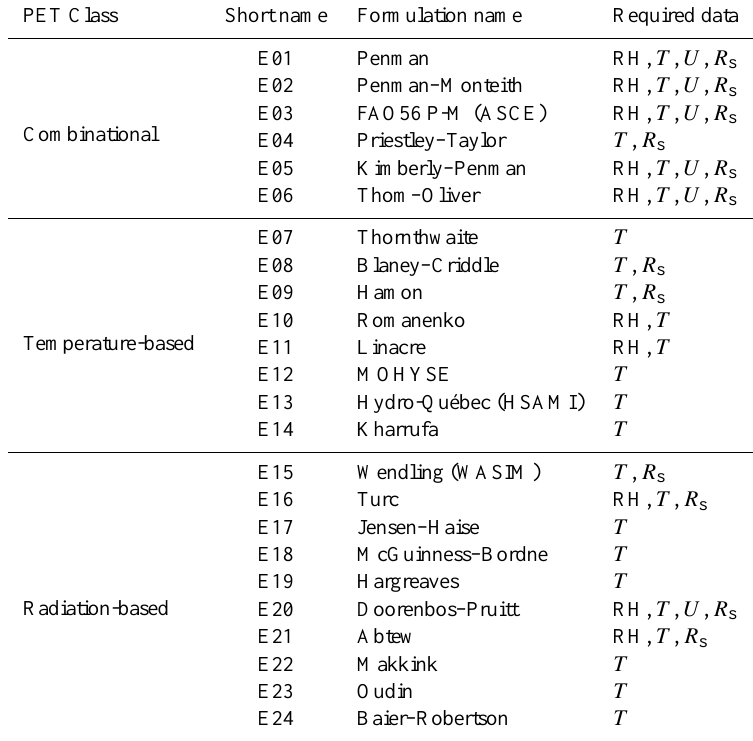
Table 2. List of the twenty-four PET formulations per category: combinational, temperature-based, and